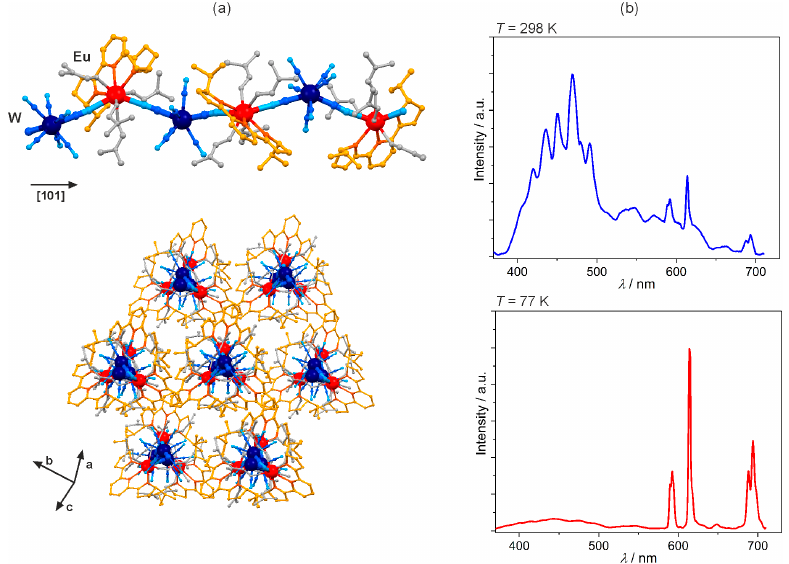
Figure 7. Crystal structure and optical properties of chiral [Eu III ( RR - i Pr-pybox)(dmf) 4 ][W V (CN) 8 ] · dmf · 8H 2 O ( RR - i Pr-pybox = RR -2,2’-(2,6-pyridinediyl)bis(4-isopropyl-2-oxazoline)) cyanido-bridged chains: ( a ) the views of the single chiral helical chain, and the arrangement of chains, ( b ) the temperature-dependent emission spectra collected under the UV light excitation of 340 nm. Colours for the structural diagram: Eu, red; W, dark blue; CN − , blue; RR - i Pr-pybox, orange; dmf, grey